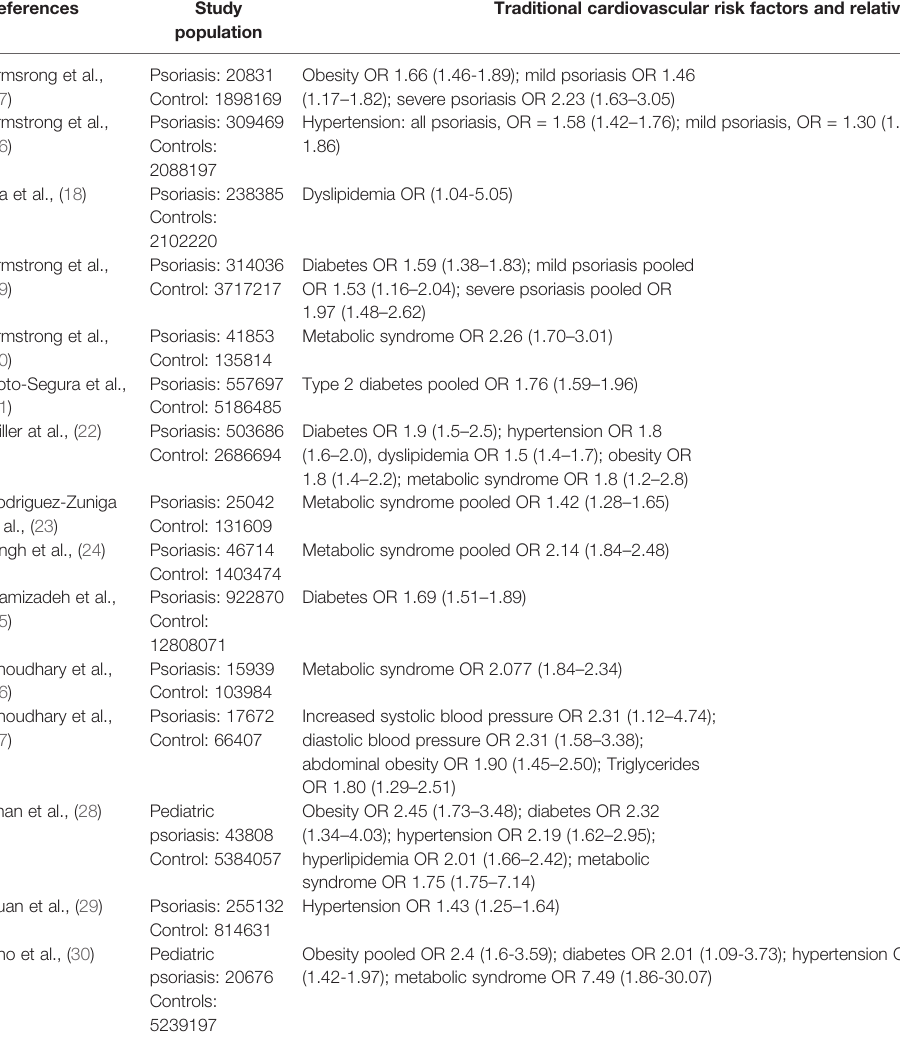
TABLE 1 | Summary of systemic reviews and meta-analysis analyzing the association between psoriasis and traditional cardiovascular risk